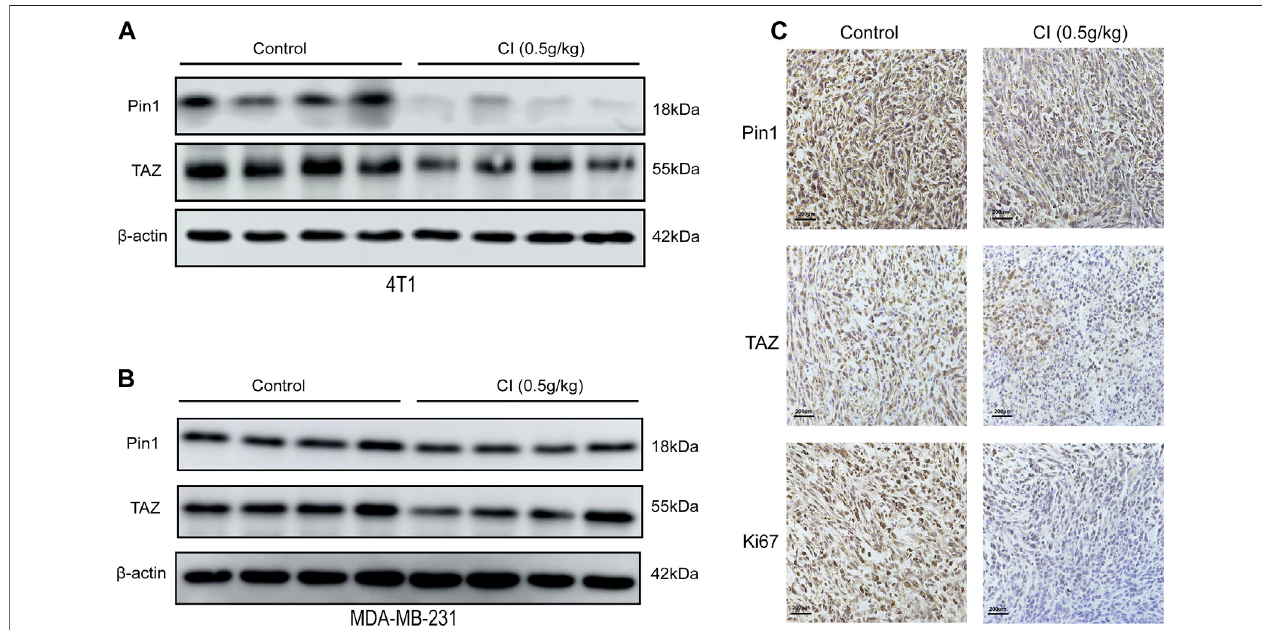
FIGURE 5 | CI regulates the Pin1 – TAZ signaling pathway. (A) Protein (Pin1 and TAZ) levels in tumor tissues of 4T1 tumor-bearing mice were detected by Western blot. (B) Protein (Pin1 and TAZ) levels in tumor tissues of MDA-MB-231 tumor-bearing mice were detected by Western blot. (C) Immunohistochemical analysis of paraf fi n-embedded 4T1 mice tumor tissue sections using antibody (Pin1, TAZ, Ki67). Scale bar stands for 200 μ m.